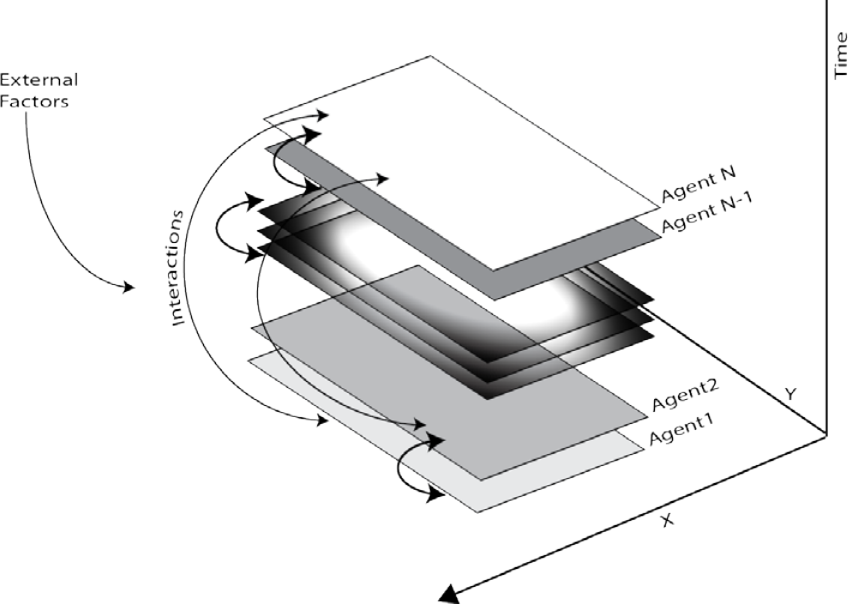
Figure 1. A 3D illustration of the layered approach where different infrastructure and decision makers are brought in as agents into the